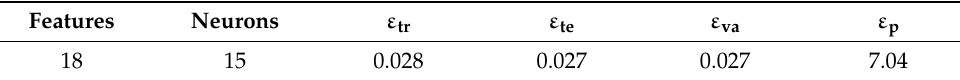
Table 7. Selected model